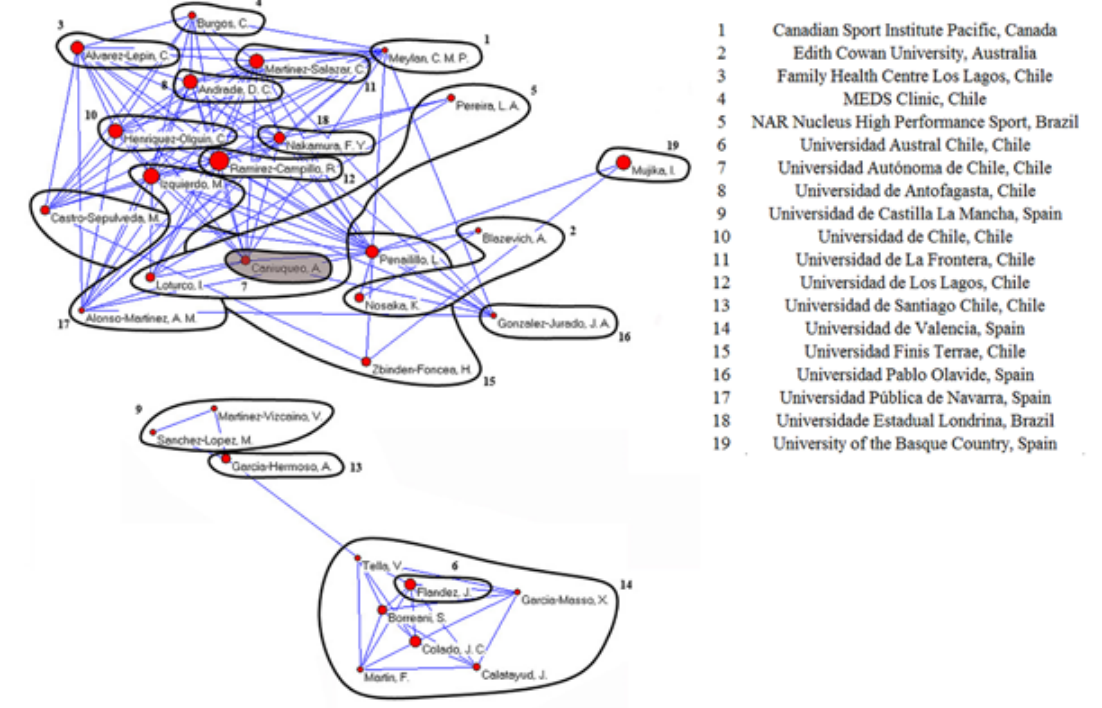
Figure 1 - Author clusters (>3 members) when a threshold of ≥3 co-authored publications is